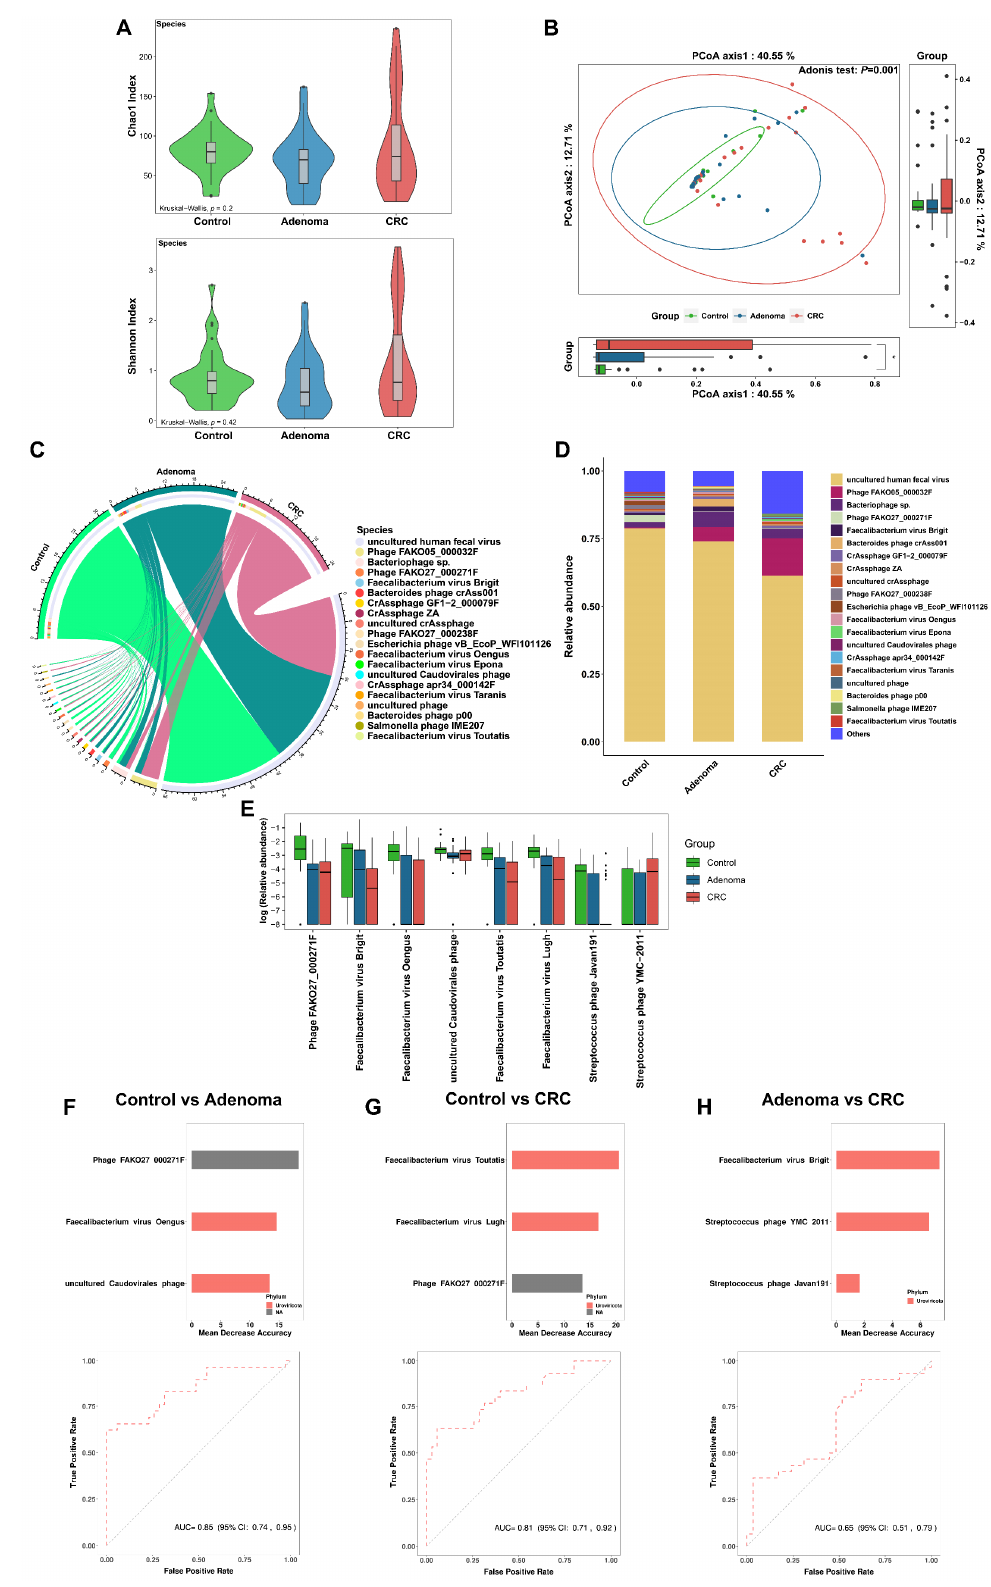
Figure 5. ( A ) The comparison of viral alpha diversity among three groups (healthy control (green), CRA (blue), and CRC (red)). ( B ) The comparison of viral beta diversity (measured by principal co- ordinates analysis, PCoA) among three groups. ( C ) The chord diagram of sample-species abundance for viruses. The upper half of the circle represents different groups (control (green), adenoma